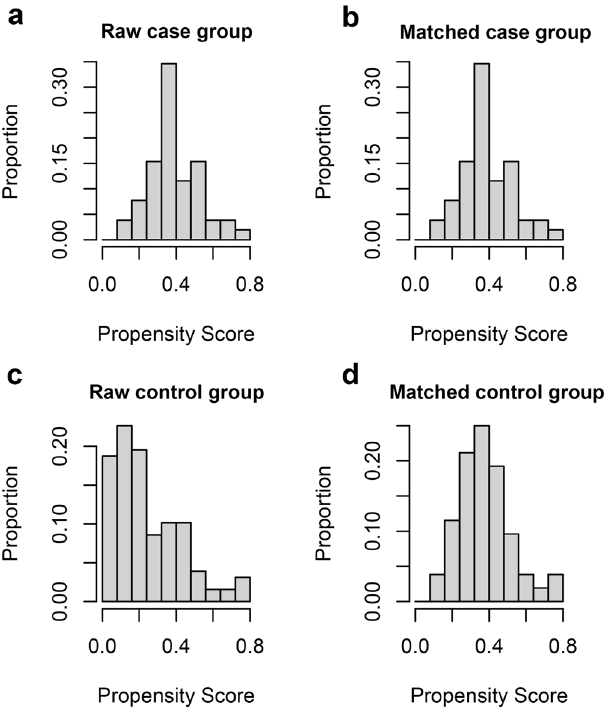
Figure 1. Propensity score matching results. ( a ) Distribution of propensity scores in the raw case group. ( b ) Distribution of propensity scores in the matched case group. ( c ) Distribution of propensity scores in the raw control group. ( d ) Distribution of propensity scores in the matched control